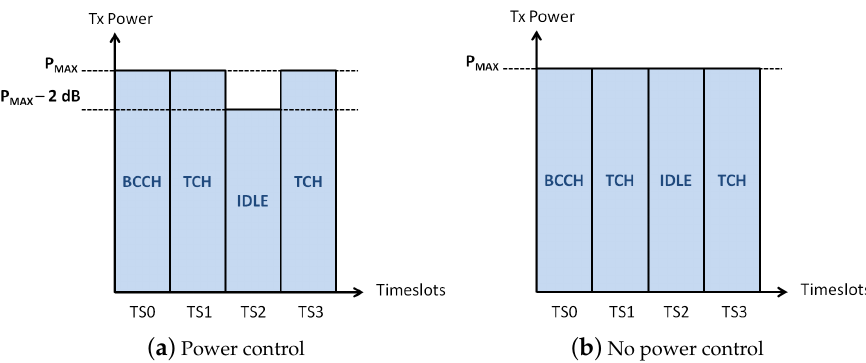
Figure 8. Transmitted signals for power control ( a ) and no power control ( b ) cases.